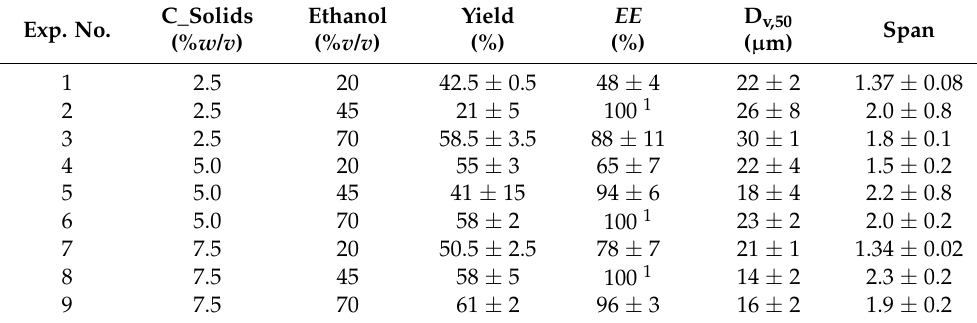
Table 3. SASD-processed GA–DPF results following the 3 2 full factorial designs. Exp. No.